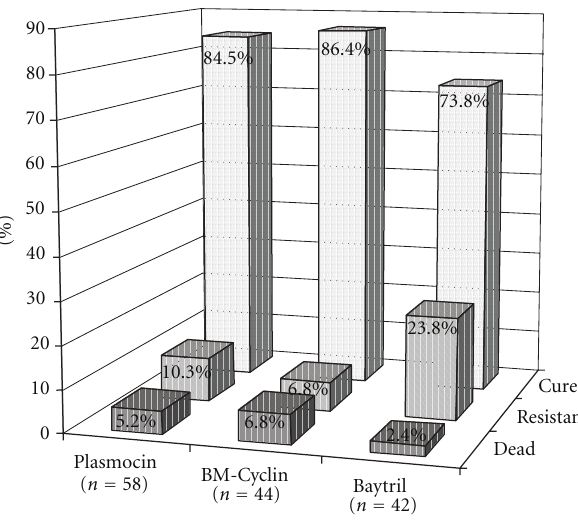
Figure 2: Relative treatment e ffi ciency of antimycoplasma antibi- otics. The portions given for Plasmocin include the results from sec- ond